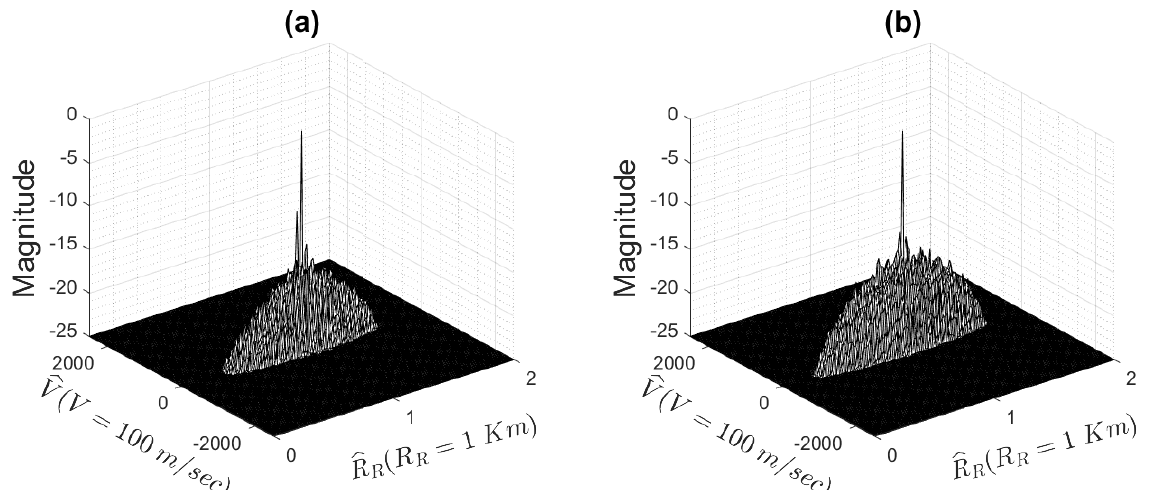
Figure 13. The cross–ambiguity surface obtained using ( a ) the Lorenz CBFM waveform and ( b ) the Burke–Shaw CBFM waveform considering the SNR = 3